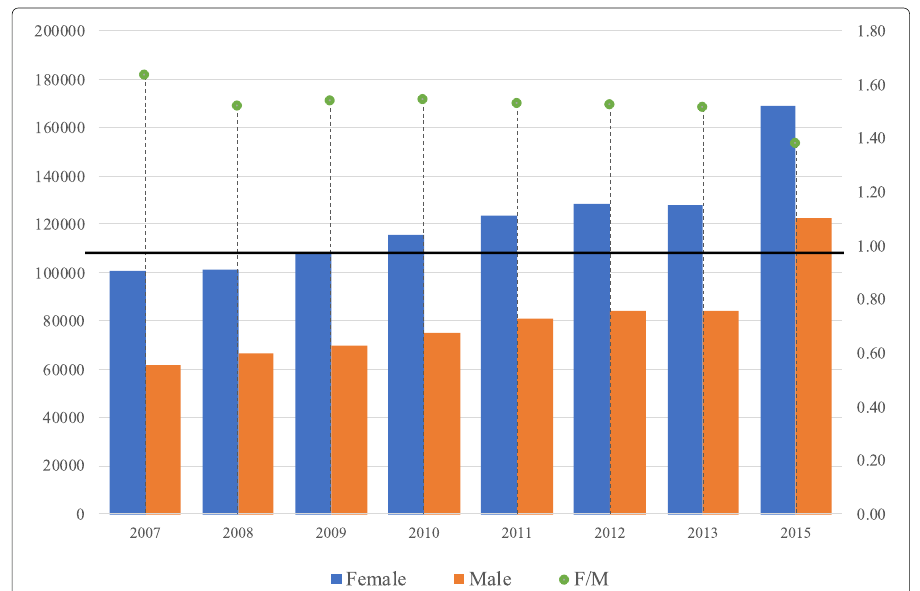
Fig. 2 Gender balance in the Erasmus mobility over selected years. The blue bars indicate the number of female Erasmus students, the orange bars indicate the number of male Erasmus students (both to be read on the left vertical axis). The green indicator represents the value of the female over male ( F / M ) ratio (right vertical axis). The horizontal line positioned at the ordinate value of 1 on the right vertical axis corresponds to F / M = 1. Information shown is based on the micro-data available on the EU Open Data Portal for the